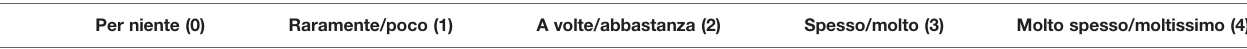
TABLE 8 | The 30-item Defense Mechanism Rating Scales Self-Report (DMRS-SR-30) questionnaire (Italian version). Nell ’ ultima settimana, quanto hai affrontato emozioni o situazioni dif fi cili nei seguenti modi? Per niente